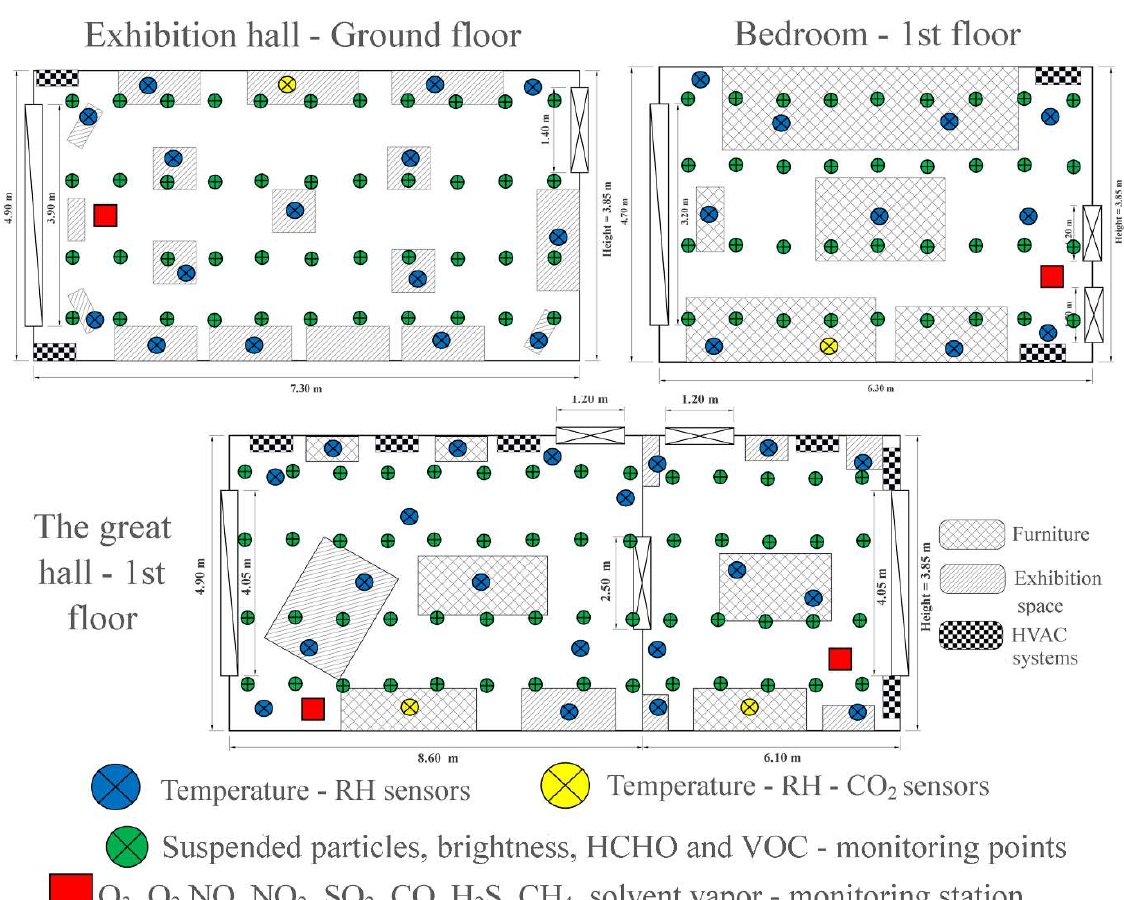
Figure 3. The three rooms analyzed within Darvas-La Roche House, the spatial distribution of sen- sors and data collection points within them. and data collection points within